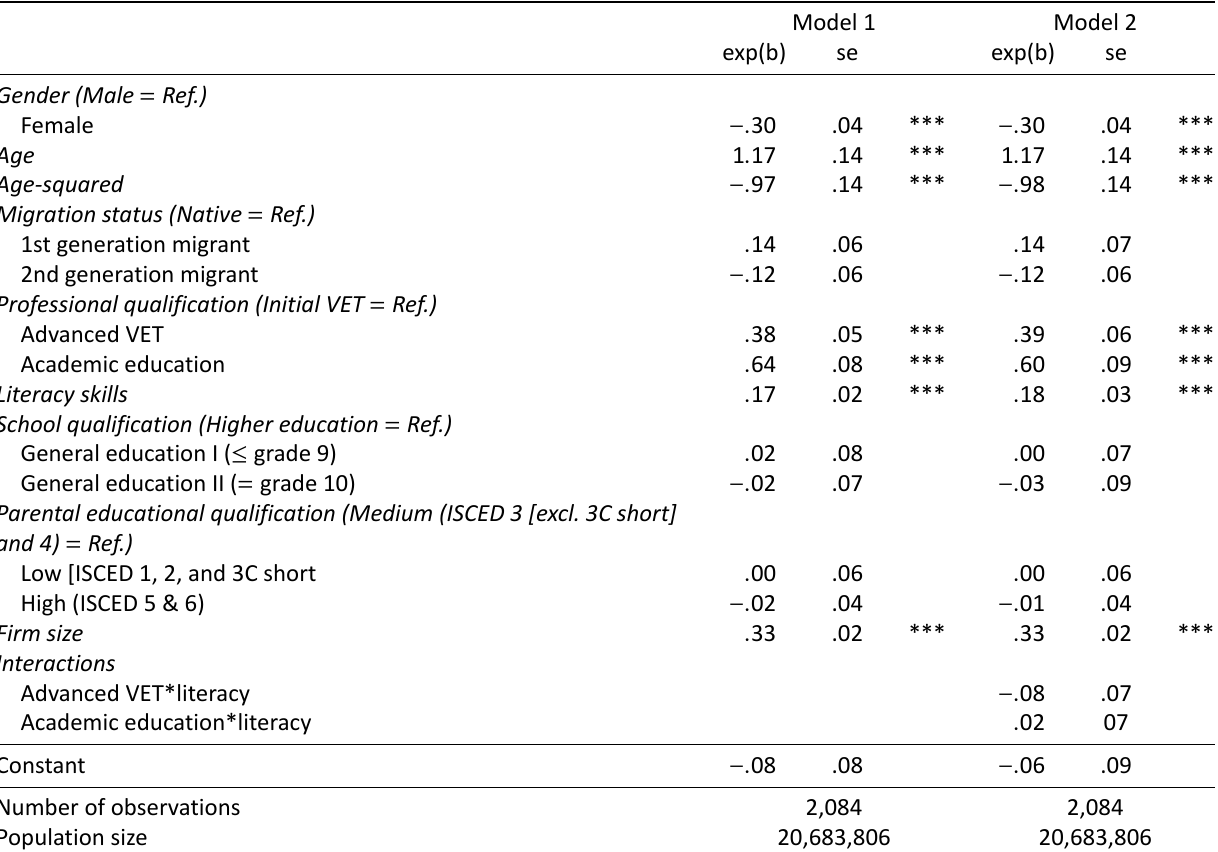
Table A1. Full regression results for hourly